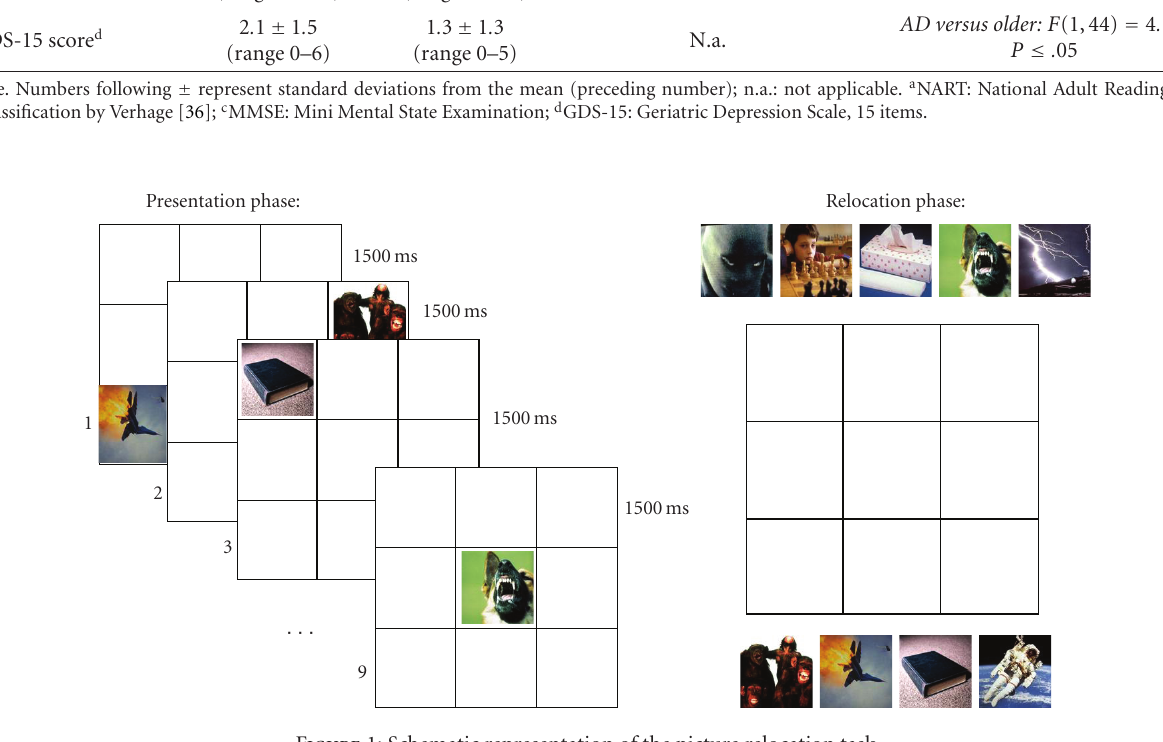
Figure 1: Schematic representation of the picture relocation task.